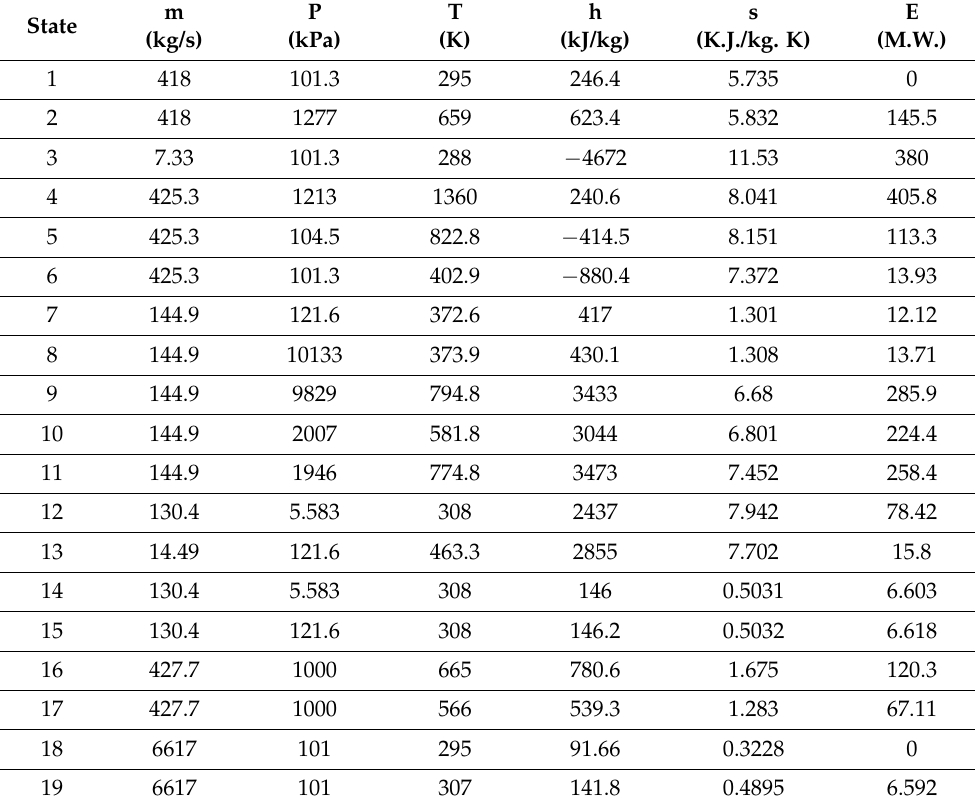
Table 7. The properties for each state for the ISCC at the optimum